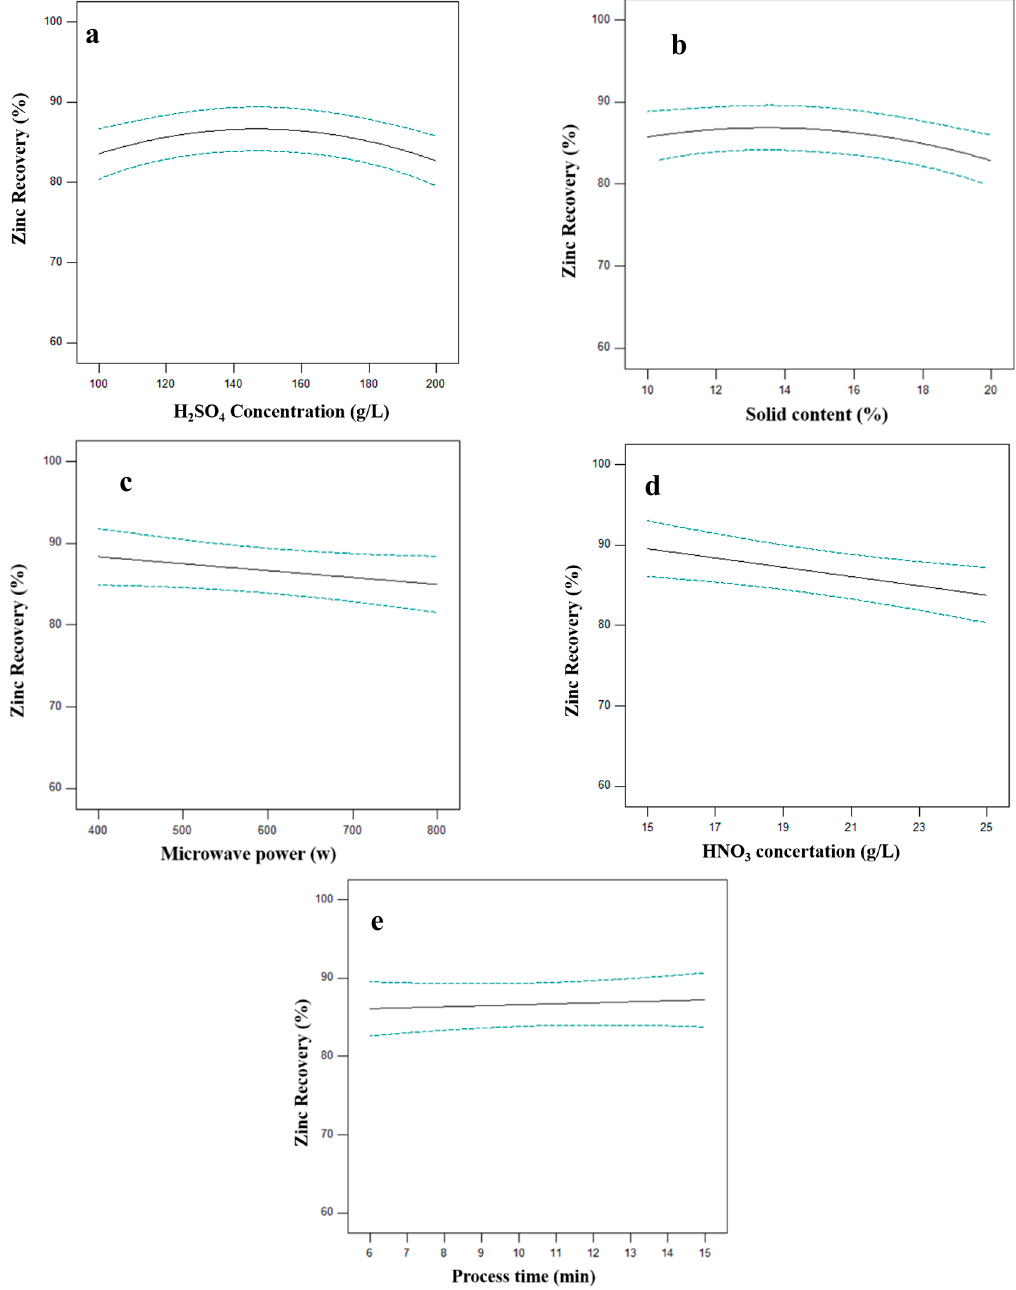
Figure 7. Effect of sulfuric acid concentration ( a ), solid content ( b ), microwave power ( c ), HNO 3 concentration ( d ) and process time ( e ) on Zn recovery (other parameters are held at center level). Among all interactions between parameters, just microwave power ‐ solid content and microwave power ‐ HNO 3 concertation interactions are meaningful (with a p ‐ value lower than 0.05).